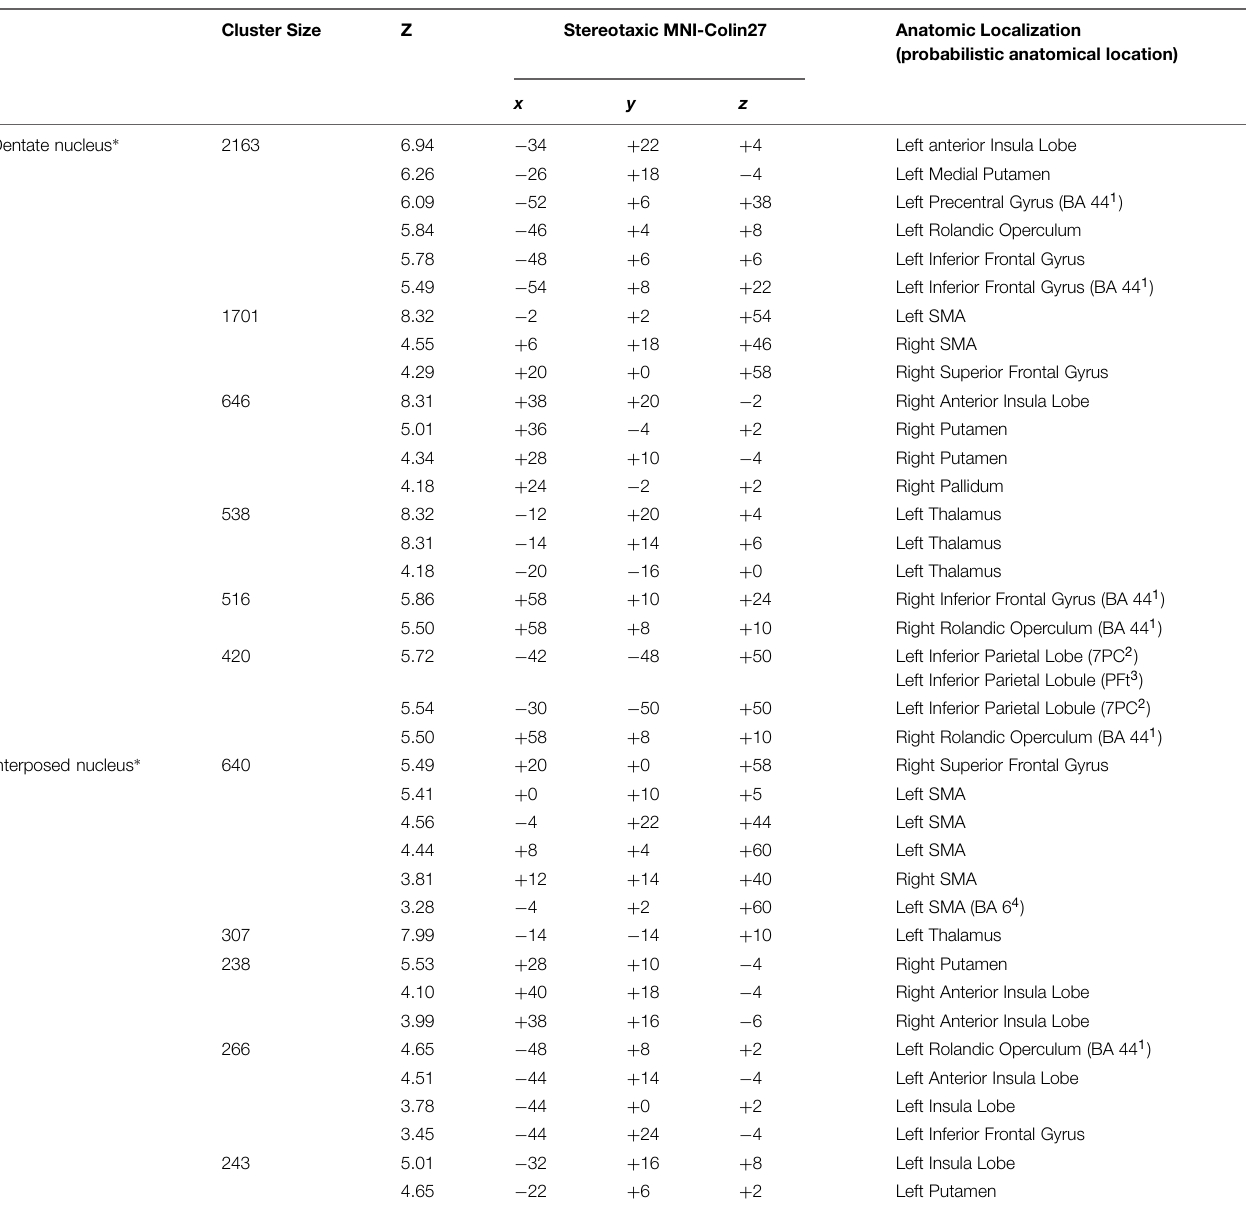
TABLE 3 | Co-activation clusters for the cerebellar